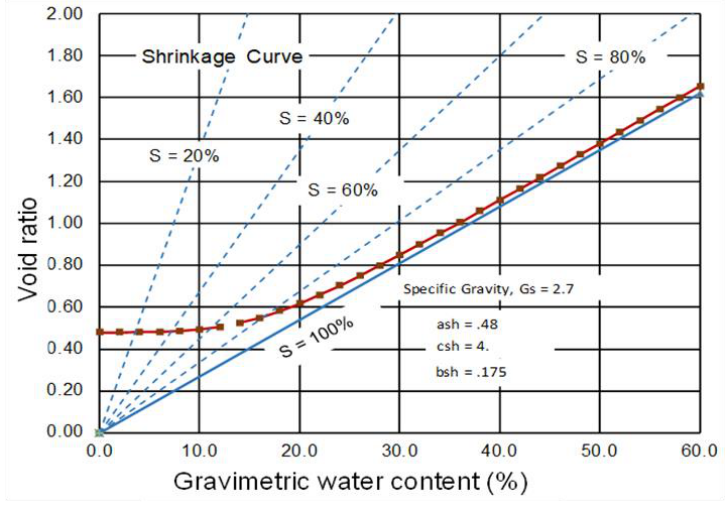
Figure 24. Prediction of the volume change using the shrinkage curve.